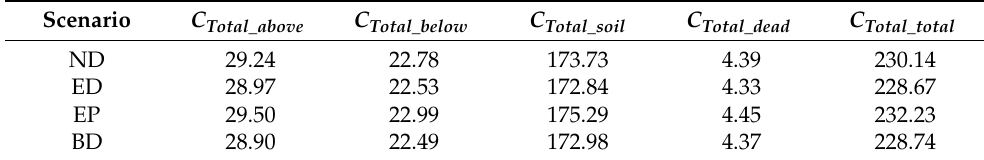
Figure 7. Prediction of the carbon storage distribution in Hangzhou under the four scenarios in 2030. Table 12. Carbon storage in Hangzhou under four scenarios in 2030 (unit: 10 6